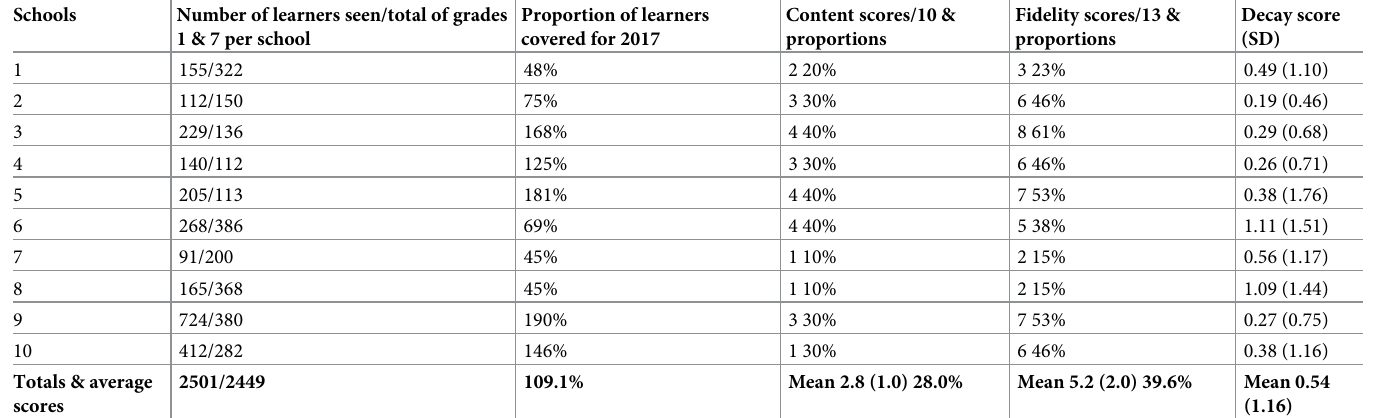
Table 1. Description of services, levels of fidelity and dental scores at school